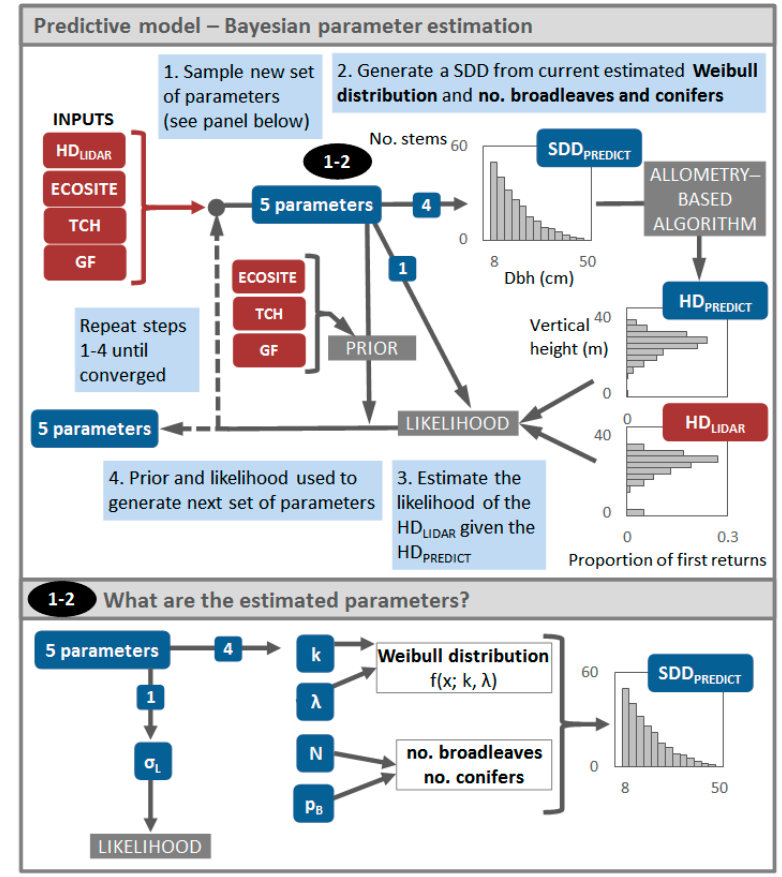
Figure 3. Overview of the Markov chain Monte Carlo approach used for estimating the parameters required to predict stem diameter distributions (SDDs). In the top panel, the HD LIDAR-SDD model includes five parameters: four to generate SDD PREDICT (from which the allometry-based algorithm goodness-of-fit between HD PREDICT and the LiDAR tile inputted into the model (HD LIDAR ). The prior calibration plots within the study area combined with a LiDAR regression and ecosite classification.